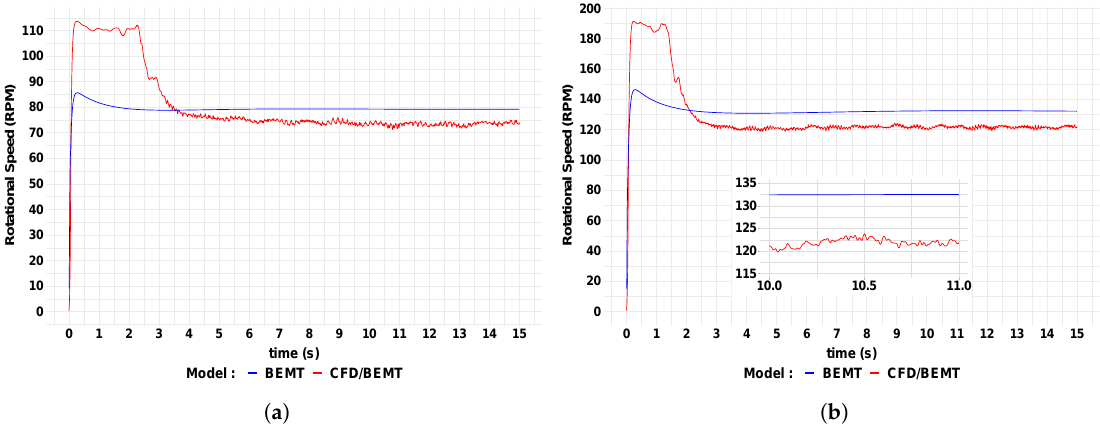
Figure 3. Rotational Speed for ( a ) Uo = 0.6 m/s and ( b ) Uo = 1.0